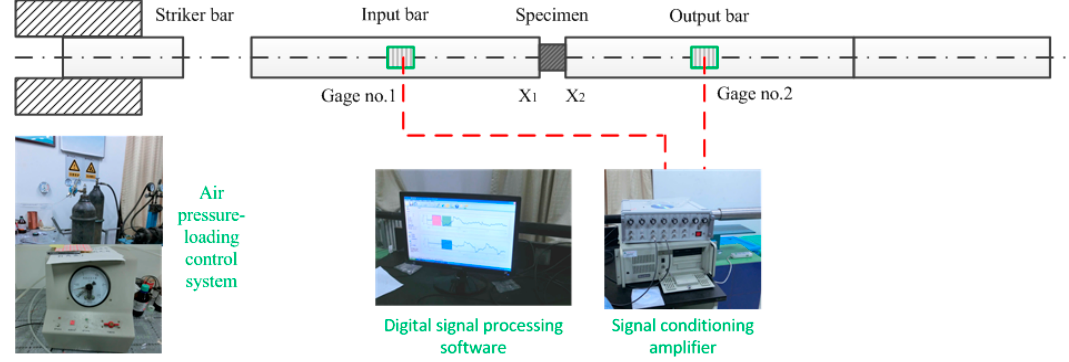
Figure 5. The schematic diagram of SHPB apparatus used in the experiment.